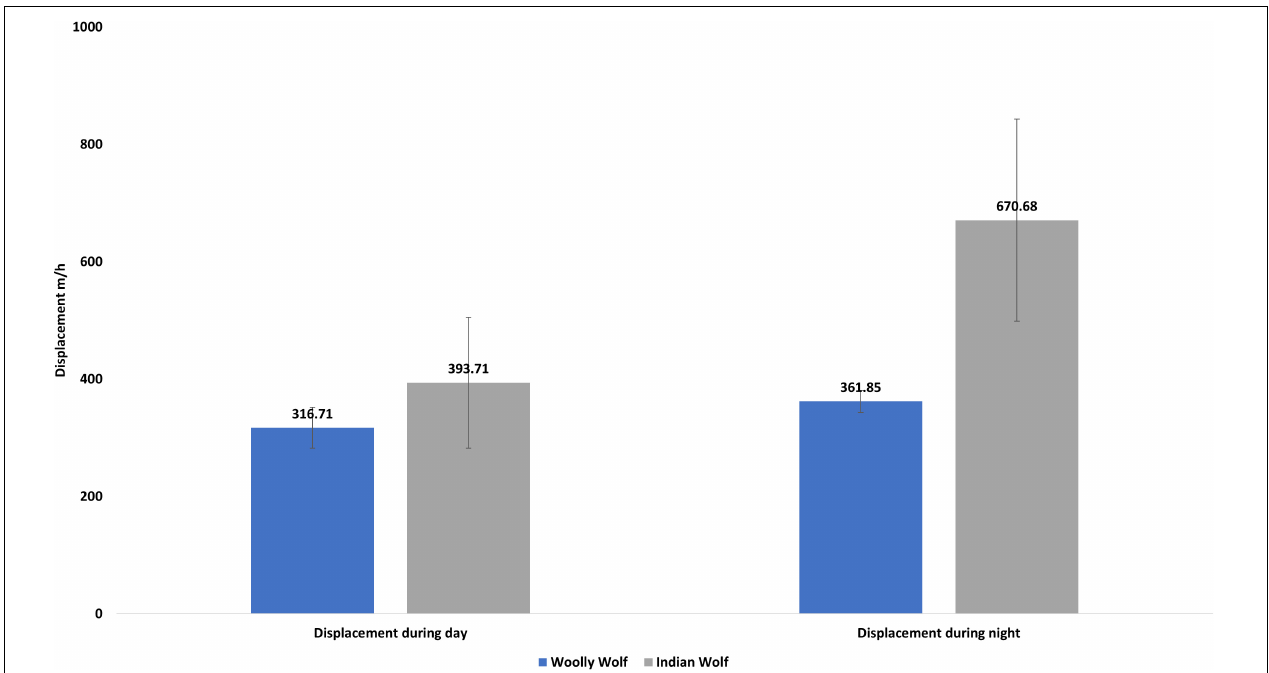
FIGURE 1 | Daily overall displacement, average daytime and nighttime displacement (meter per hour; m/h) of the Woolly and Indian